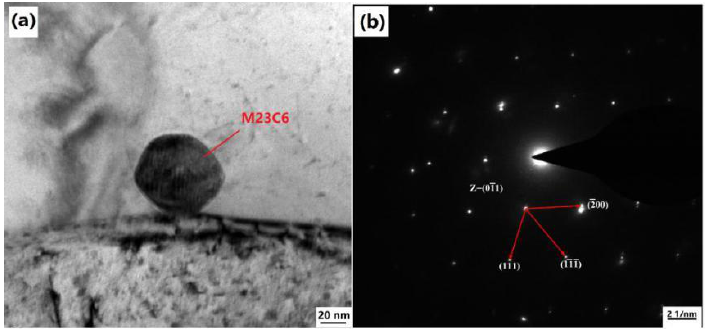
Figure 15. TEM results of M 23 C 6 : ( a ) bright field and ( b ) selected area electron diffraction.